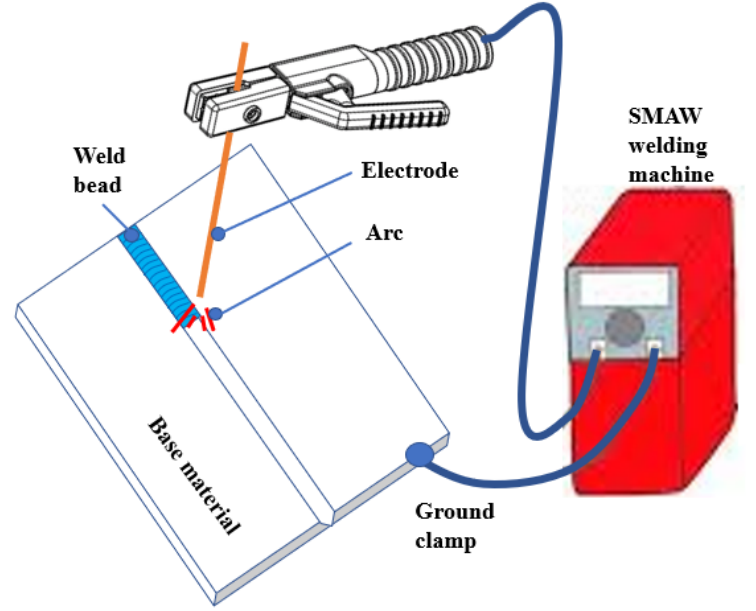
Figure 2. Mechanism of SMAW welding process.